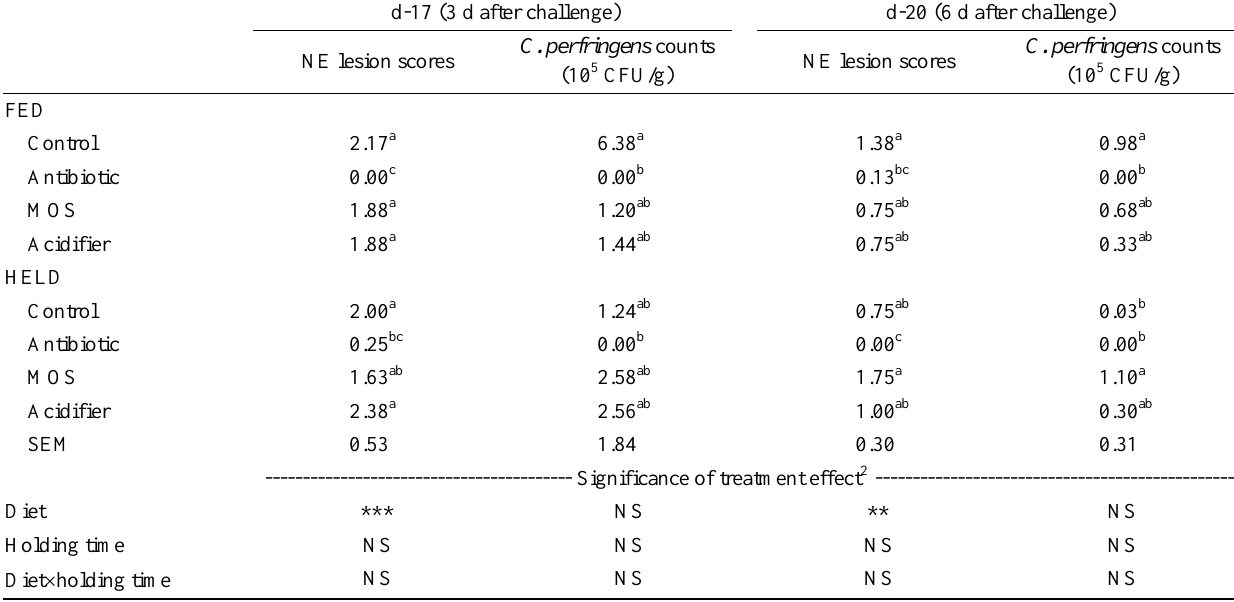
Table 4. Effects of post hatch holding time and dietary supplements on NE lesion scores and C. perfringens counts 3 and 6 days